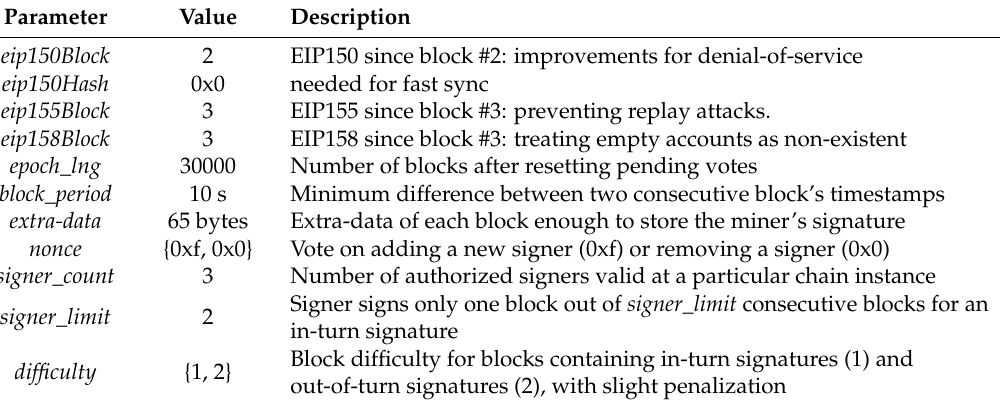
Table 1. Configuration parameters for private Ethereum network and PoA